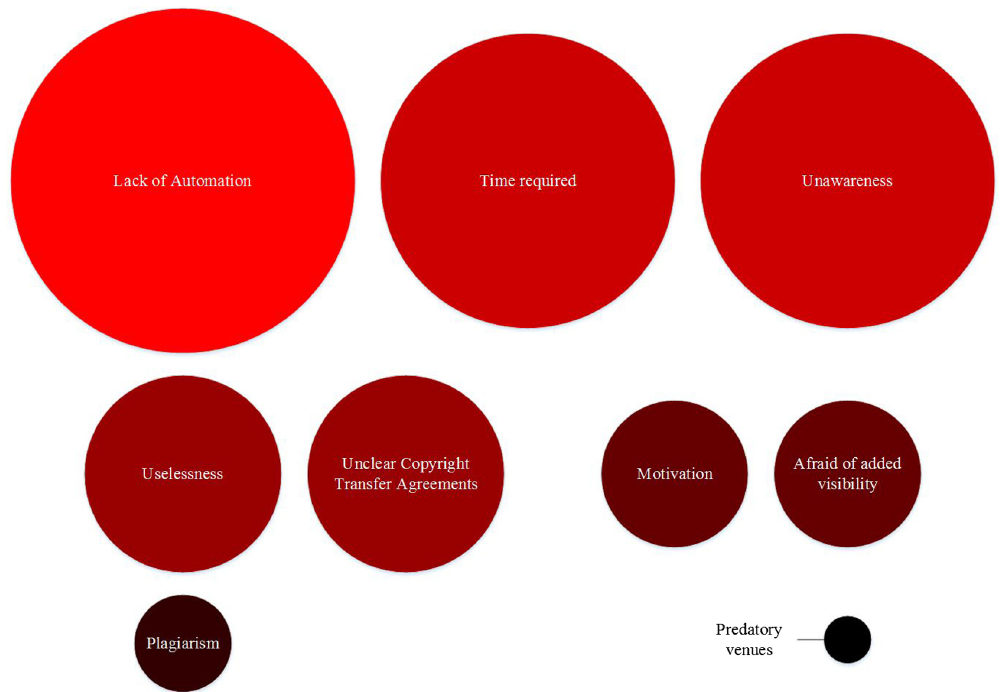
Figure 7. Identi fi ed factors inhibiting